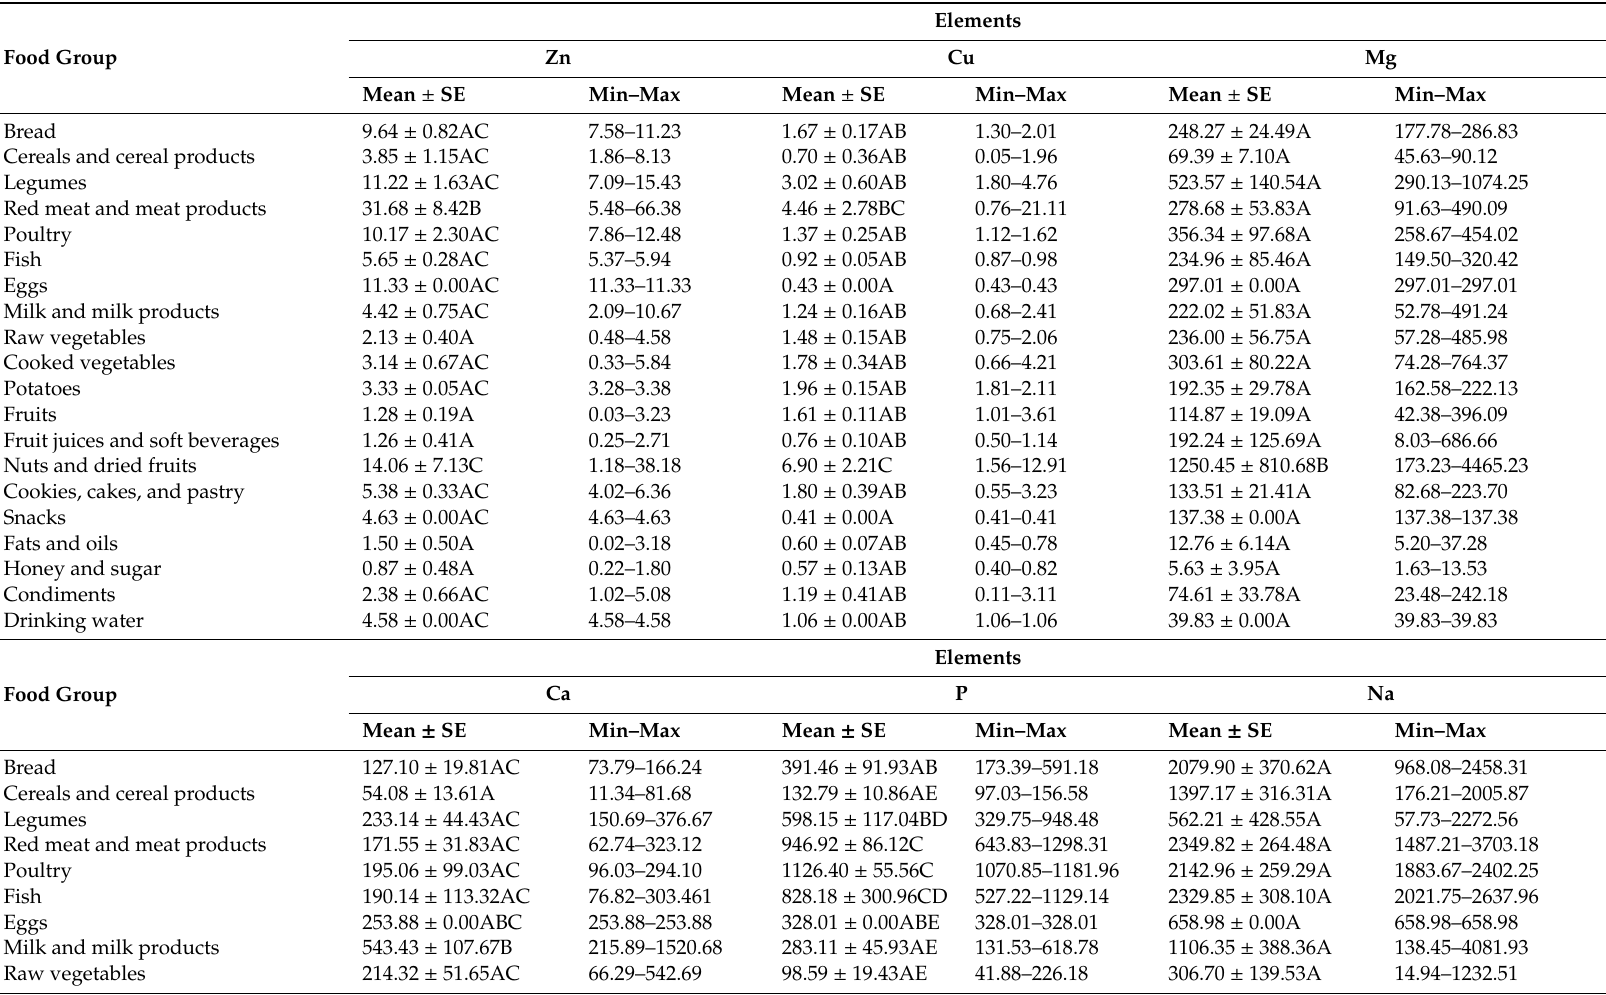
Table 3. The mean, minimum, and maximum concentrations (mg / kg fresh weight) of zinc (Zn), copper (Cu), magnesium (Mg), calcium (Ca), phosphorus (P), and sodium (Na) in foods “as consumed” at food group level in Shiraz, Iran Total Diet